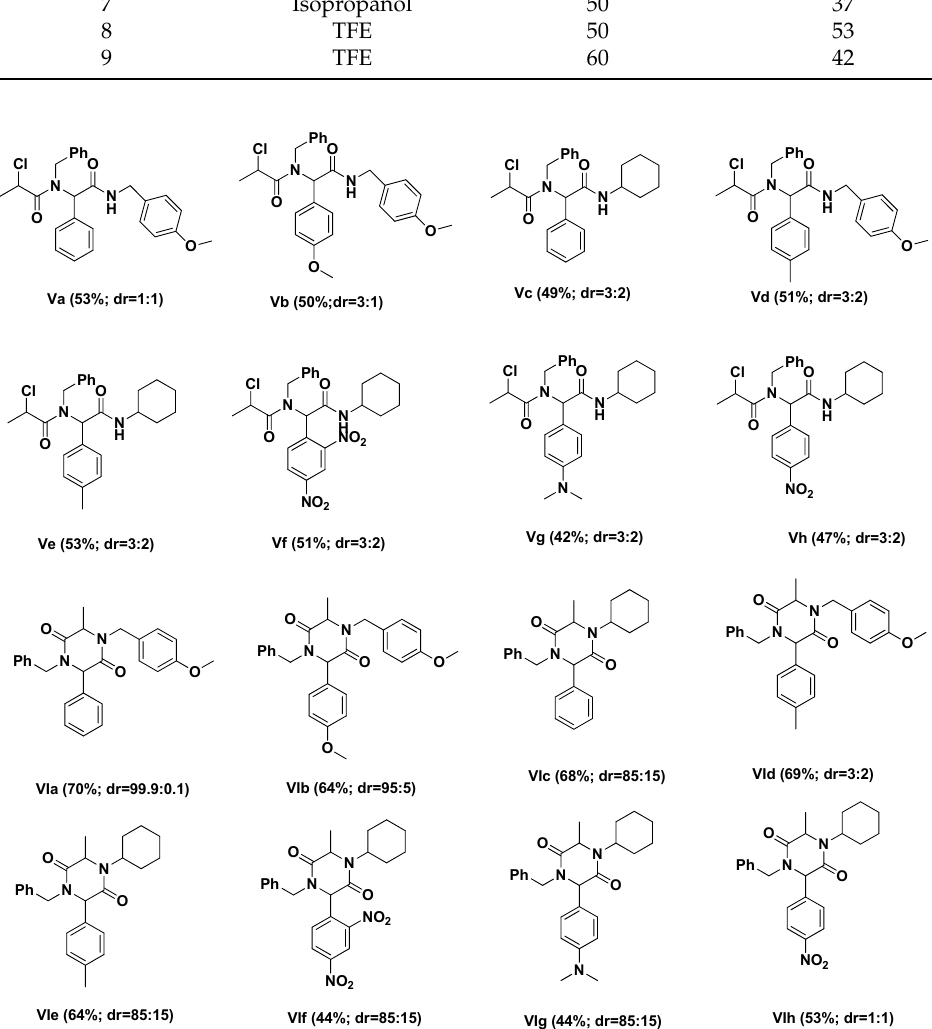
Figure 2. Structures of investigated peptidomimetics and DKPs with isolated yield and diastereomeric ratio in brackets. Table 2. Optimization for model cyclisation reaction.